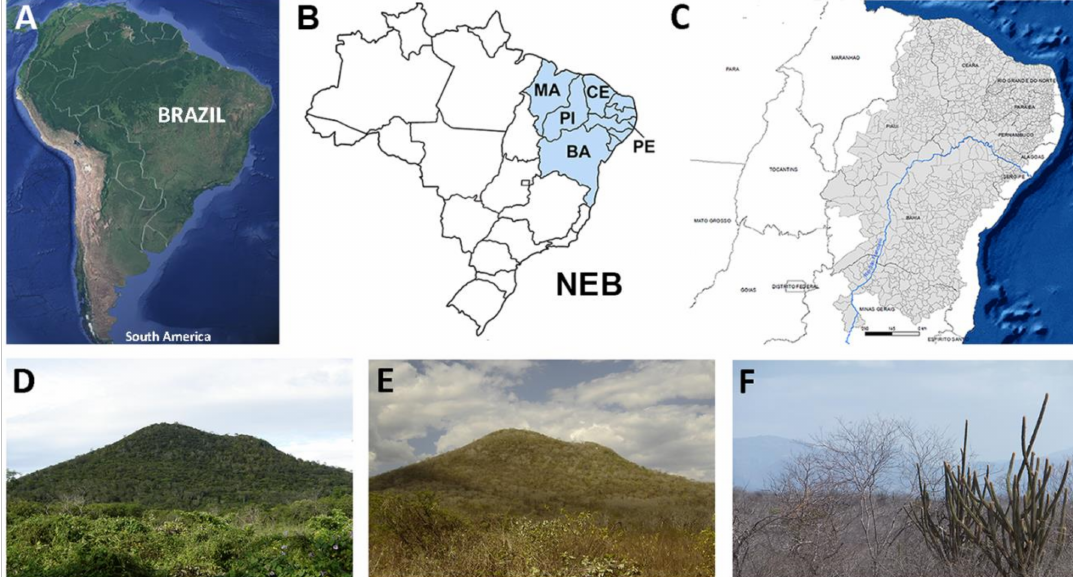
Figure 2. Geographic and biogeographic information of Brazil. South America map showing location of Brazil ( A ). Map depicting Brazil localization. Northeastern Brazil (NEB) is shown in blue ( B ). Coccididoiomycosis occurs in the States of Maranh ã o (MA), Piau í (PI), Cear á (CE), Pernambuco (PE), and Bahia (BA). All States are located in the semi-arid area (grey) of NEB ( C ). Caatinga vegetation in Cear á State during rainy ( D ) and dry seasons ( E ). Detail of the Caatinga vegetation during the dry season showing xerophytic plants and deciduous trees and shrubs ( F